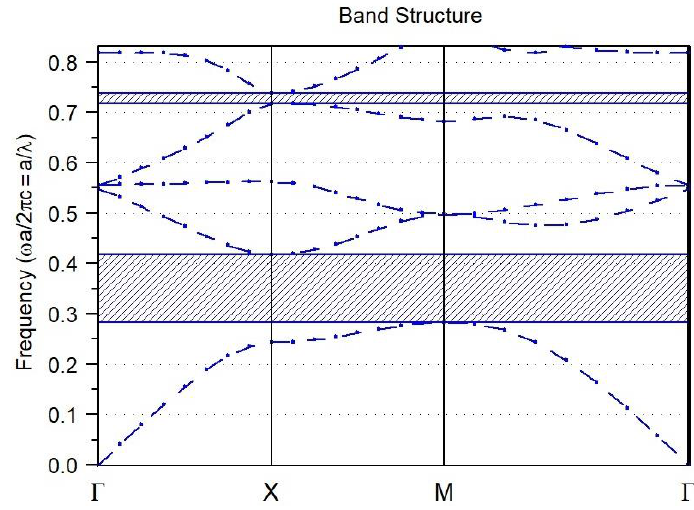
Figure 1. PBG range for the basic structure.